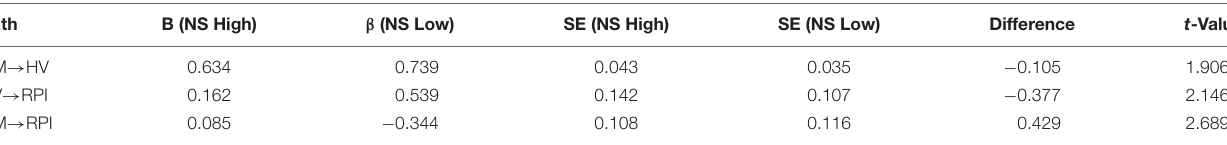
FIGURE 5 | Results of PLS-SEM hypothesis testing on the global model. TABLE 8 | Result of multi-group